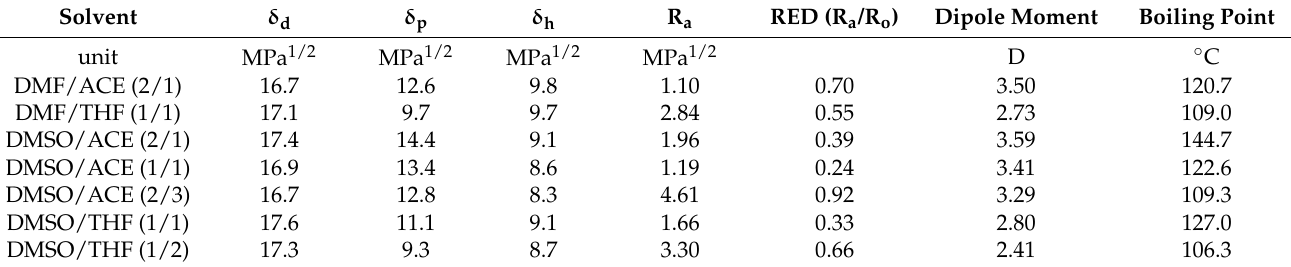
Table 2. Hansen solubility parameters and physical properties of the mixed solvents.